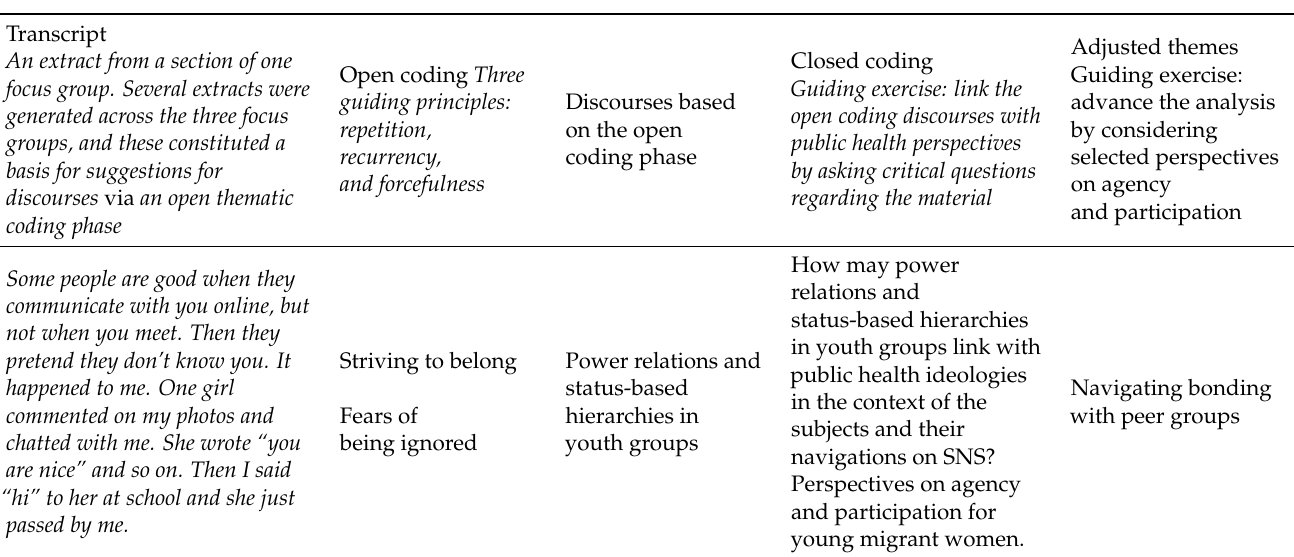
Table 1. Example of structured evolution of themes.